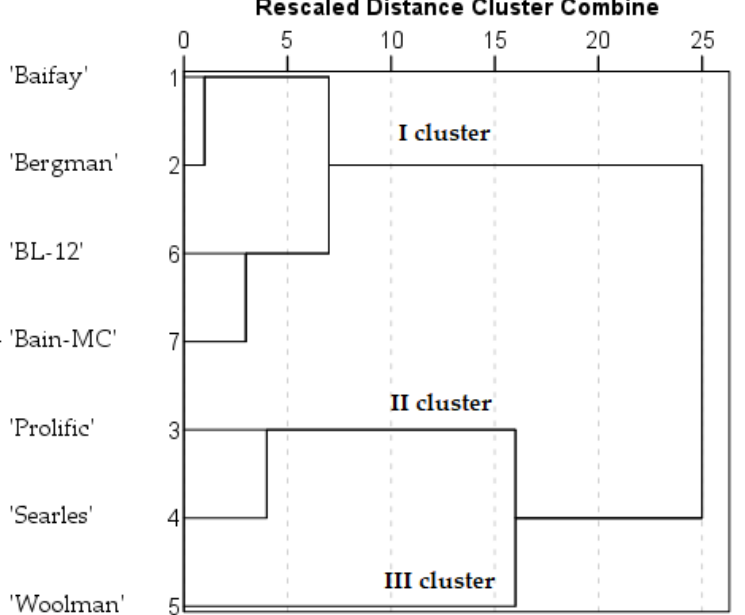
Figure 3. A dendrogram of the distribution of American cranberry cultivars into similar clusters according to the chlorogenic acid and flavonols content in fruit samples.